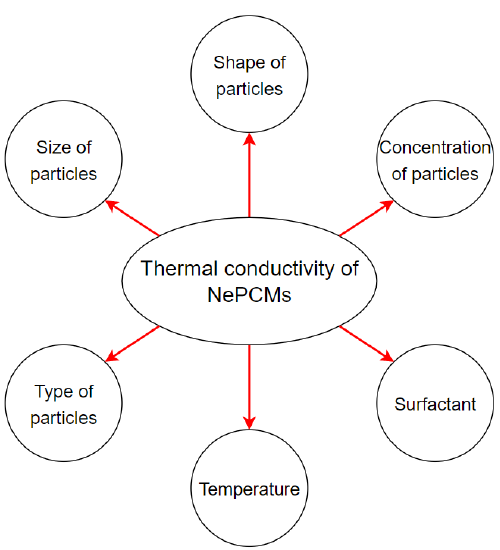
Figure 2. Influential factors affecting NePCMs’ thermal conductivity. Adapted with permission from Ref. [21]. Copyright 2019 Journal of Energy Storage.